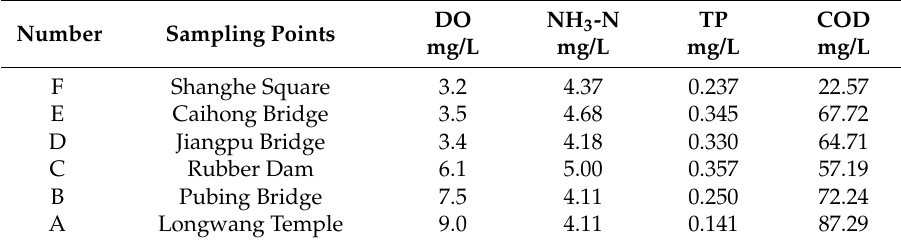
Table 1. Background Values of Water Quality of Chengnan River.